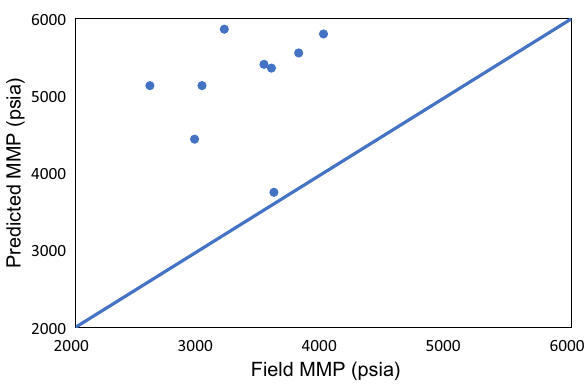
Fig. 9 Cross-plot of MMP testing data for Firoozabadi and Aziz (1986) correlation